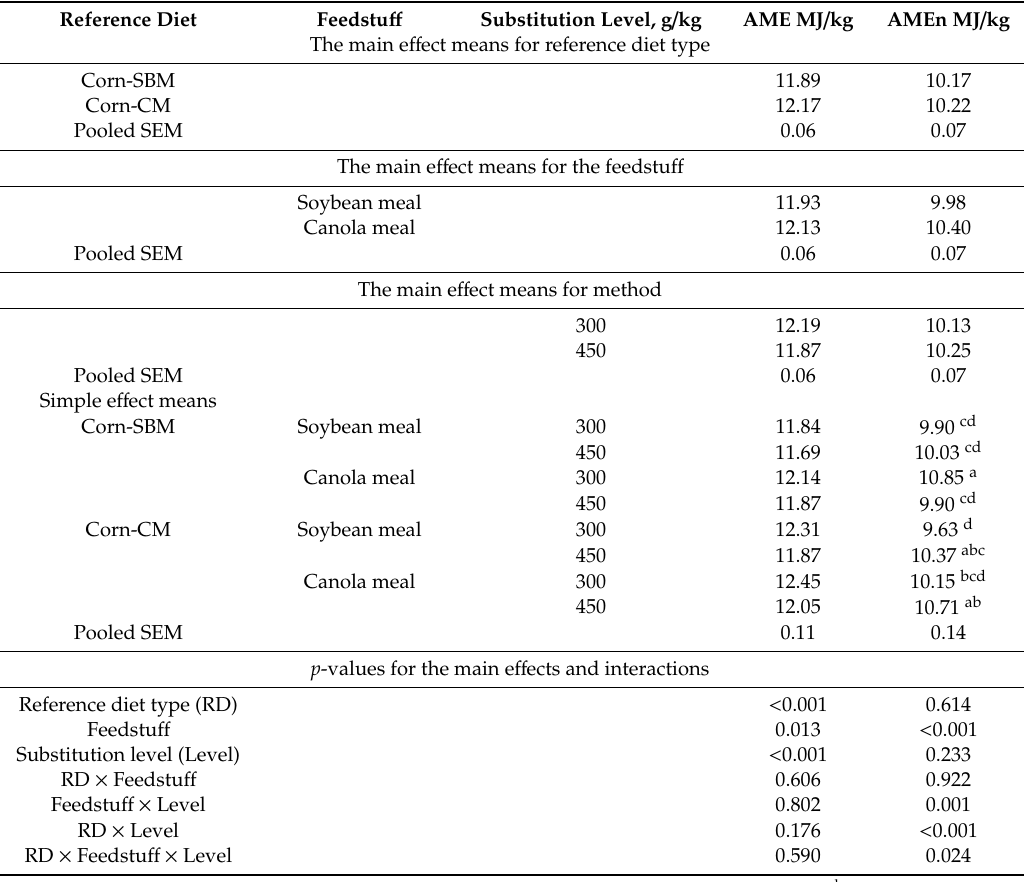
Table 3. Influence of reference diet type and substitution levels on apparent metabolizable energy and nitrogen-corrected metabolizable energy values of soybean meal or canola meal determined by the di ff erence method.